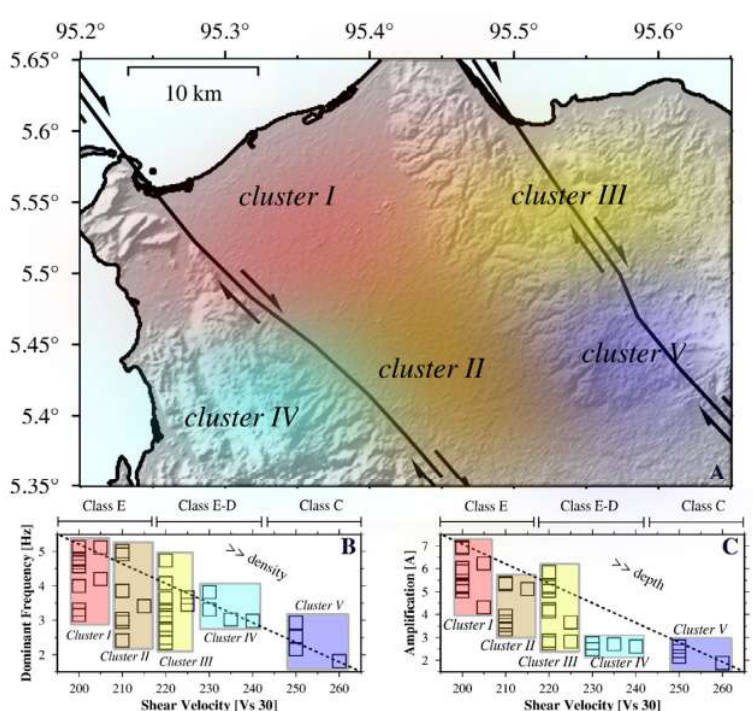
Fig. 9: Clusters of zonation derived from the combination of Vs , dominant frequency and amplification (A). There is five clusters specifically located by different parameters, Cluster I in the Banda Aceh Basin, called the Banda Aceh cluster, Cluster II in the southern part of Basin Aceh, called the Jantho cluster, cluster III in the northern part of Seulimeum fault, called the Krueng Raya cluster, cluster IV along Aceh fault, called the Lhoknga-Lhoong cluster, and cluster V along Seulimeum fault and Mount Volcano of Seulawah Agam, called the Seulawah